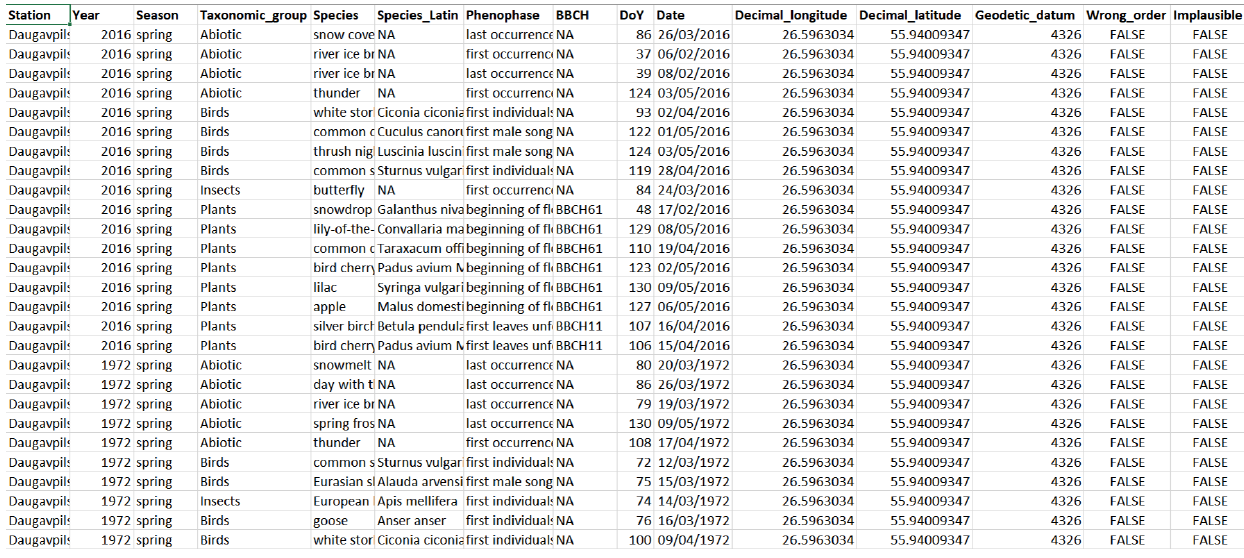
Figure 5. An excerpt from the database showing the structure of the